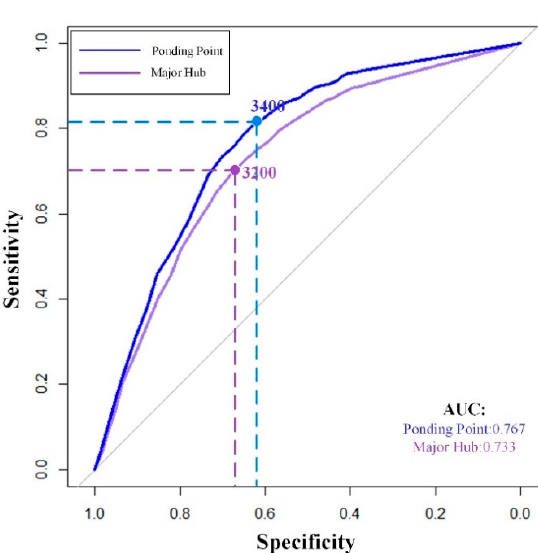
Figure 14. The ROC curves of the influencing factors.